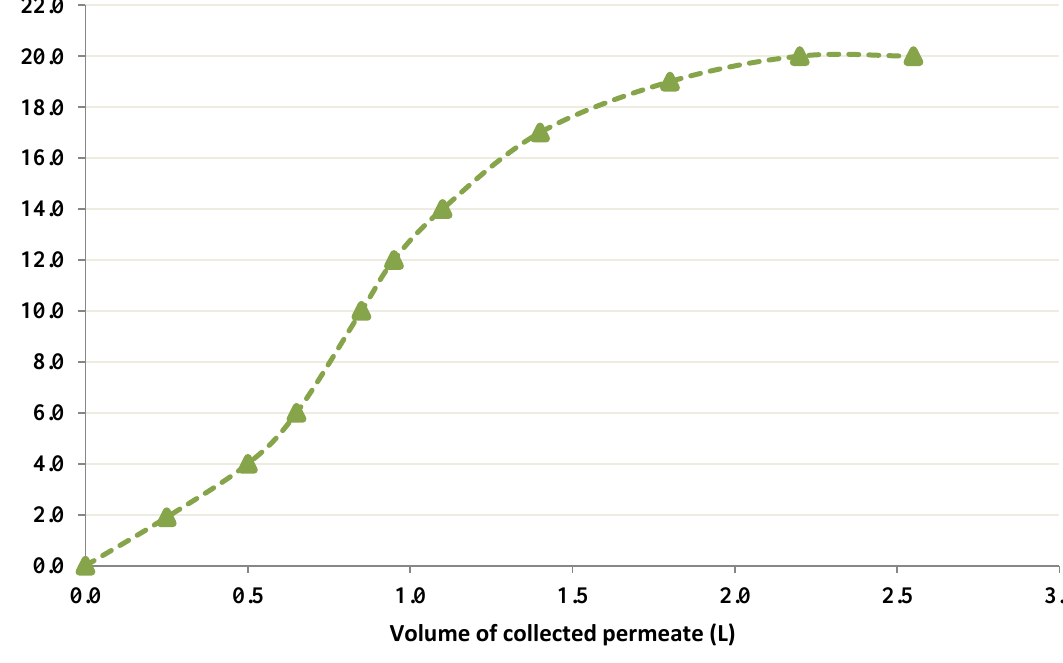
Figure 6. Permeation curve without chitin and with the Co feed solution (20 mg/L).